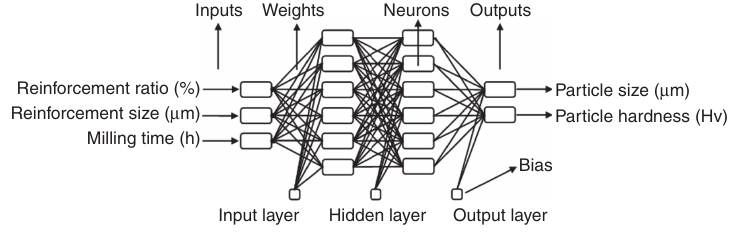
Figure 4 ANN architecture selected as prediction model for the particle size ( μ m) and particle hardness